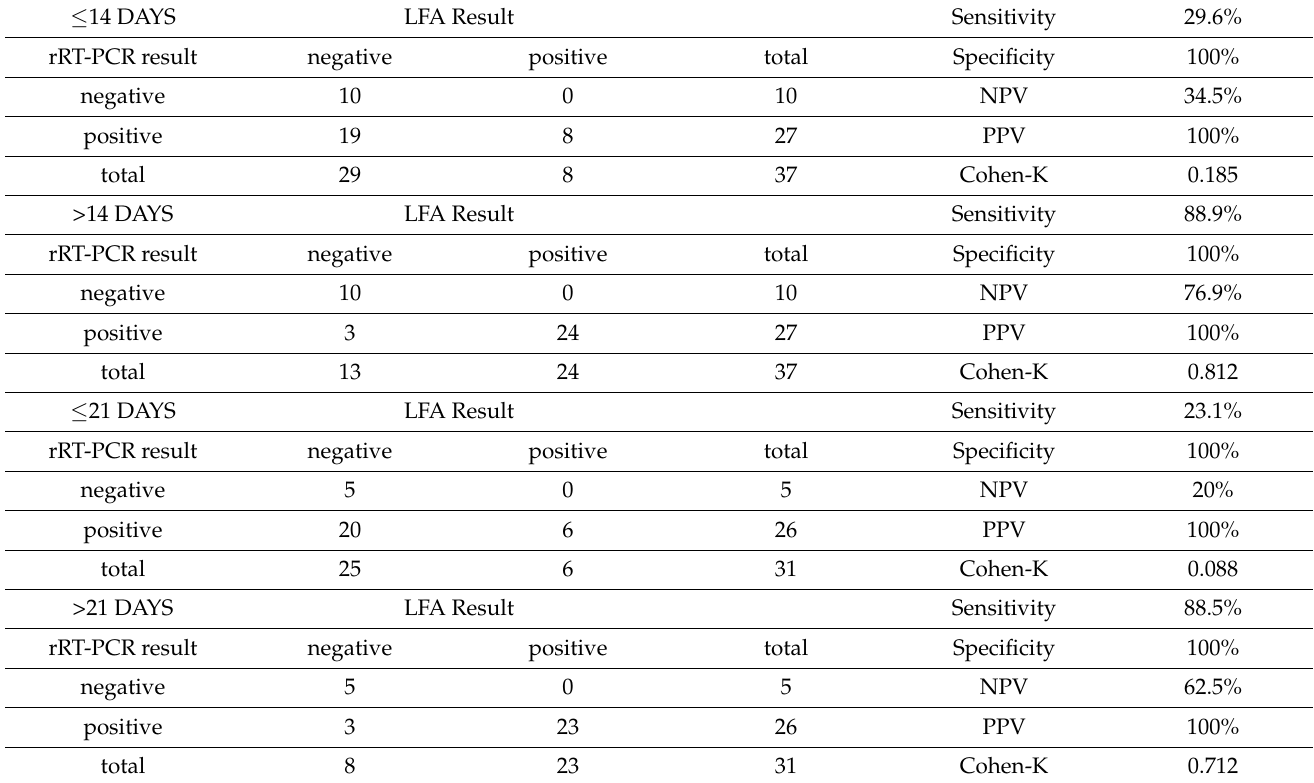
Table 2. Evaluation of the change in analytical performance of LFA in patients who underwent multiple tests. The timing is relative to the rRT-PCR